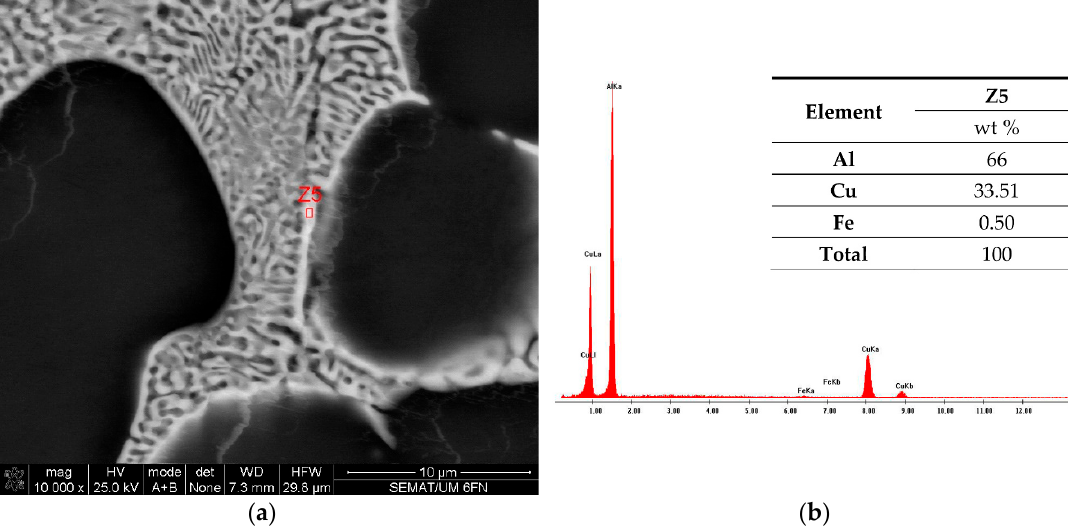
Figure 10. ( a ) Fe trace which appeared in few limited points in the second phase, batch 45U. ( b ) EDS quantification of the point in ( a ).